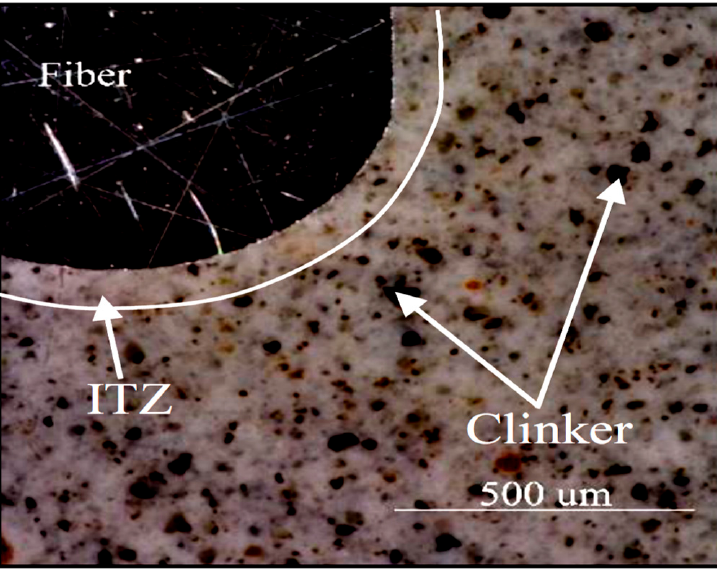
Figure 5. SEM image of steel fibre–matrix interfacial zone in the matrix (ITZ) [46].